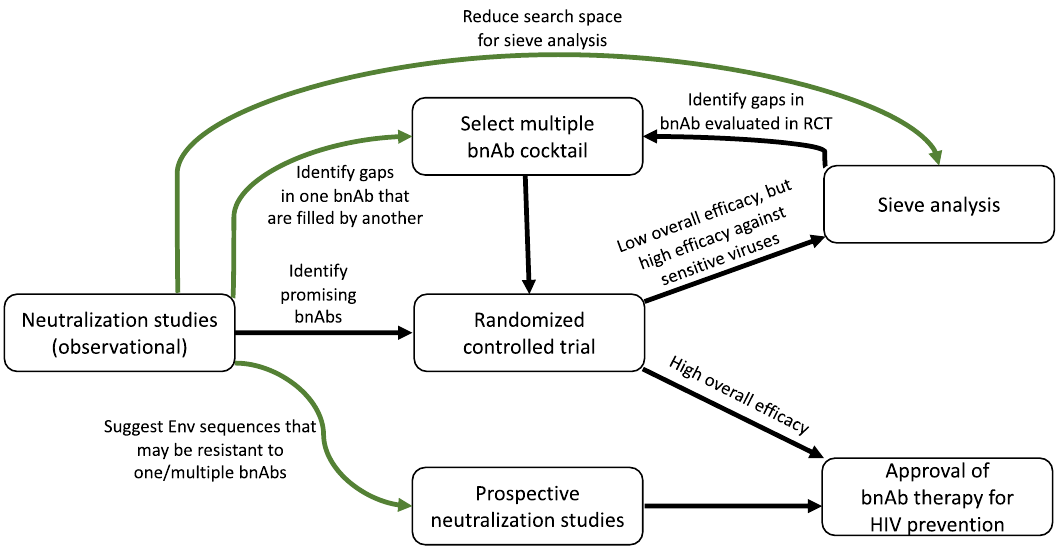
Figure 2: Illustration of the interplay between observational neutralization studies and randomized controlled trials of bnAb therapies for prevention. Green arrows illustrate where our proposed method may contribute to the